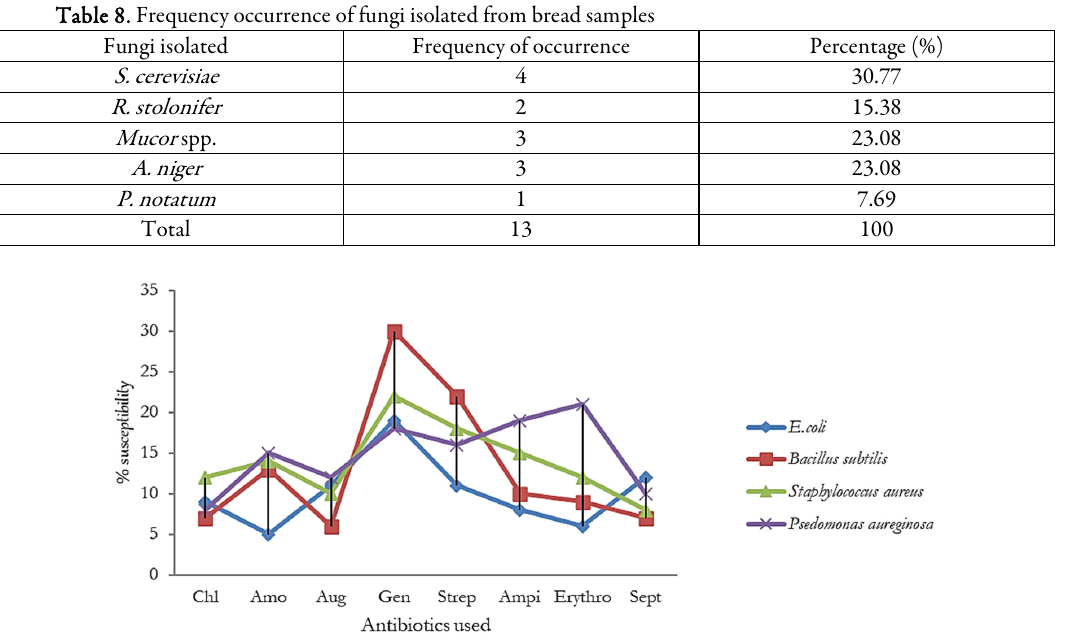
Figure 1. Antibiotic susceptibility profile of bacterial isolated from bread Chl – Chloramphenicol, Amo – Amoxicillin, Aug – Augumentin,Gen – Gentamycin, Strp- Streptomycin, Ampi – Ampicillin, Erythro – Erythromycin Sept –